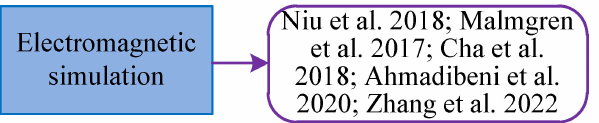
Figure 14. Electromagnetic simulation for generating new samples in SAR ATR